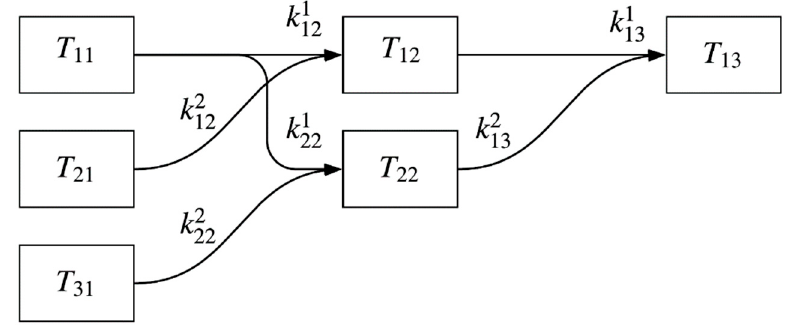
Figure 2. High-order extrapolation table.